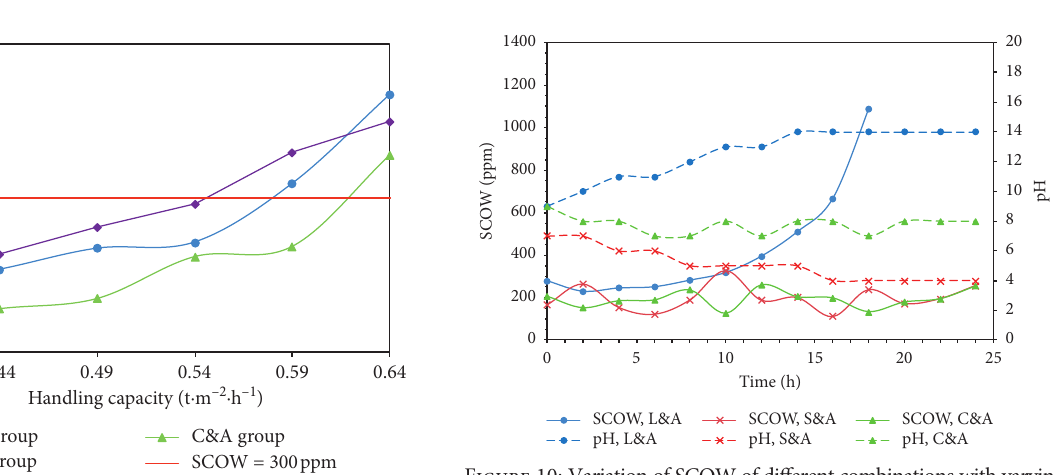
Figure 8: (a) Height variation of solid-liquid interface with time when the addition of calcium chloride was 3kg/t and the APAM changed from 10g/t to 40 g/t; (b) the effect of FS at calcium chloride of 3 kg/t and APAM of 30g/t.